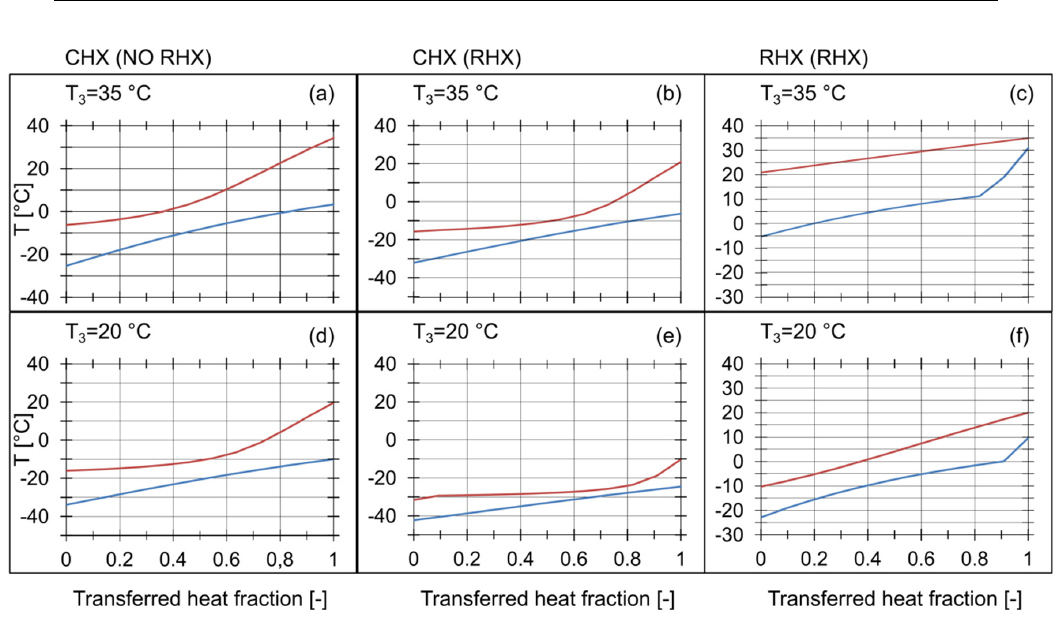
Figure 7. Q-T diagram for di ff erent condensing temperatures with and without the RHX across: ( a ) CHX without RHX at T 3 = 35 °C, ( b ) CHX with RHX at T 3 = 35 °C, ( c ) RHX with T 3 = 35 °C, ( d ) CHX without RHX at T 3 = 20 °C, ( e ) CHX with RHX at T 3 = 20 °C, ( f ) RHX with T 3 = 20